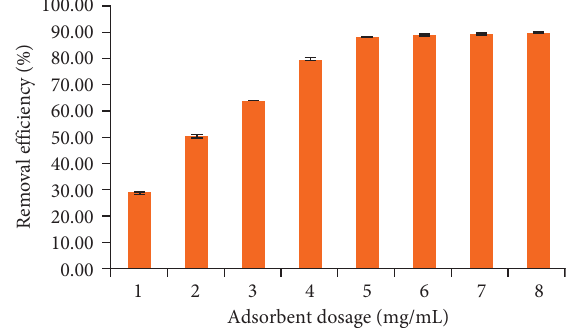
Figure 4: Effect of adsorbent dosage to the TC removal onto NCPML ( C i (TC) � 10 mg/L), pH 4, and contact time 180min. Error bars indicate the standard deviations of three replicates.